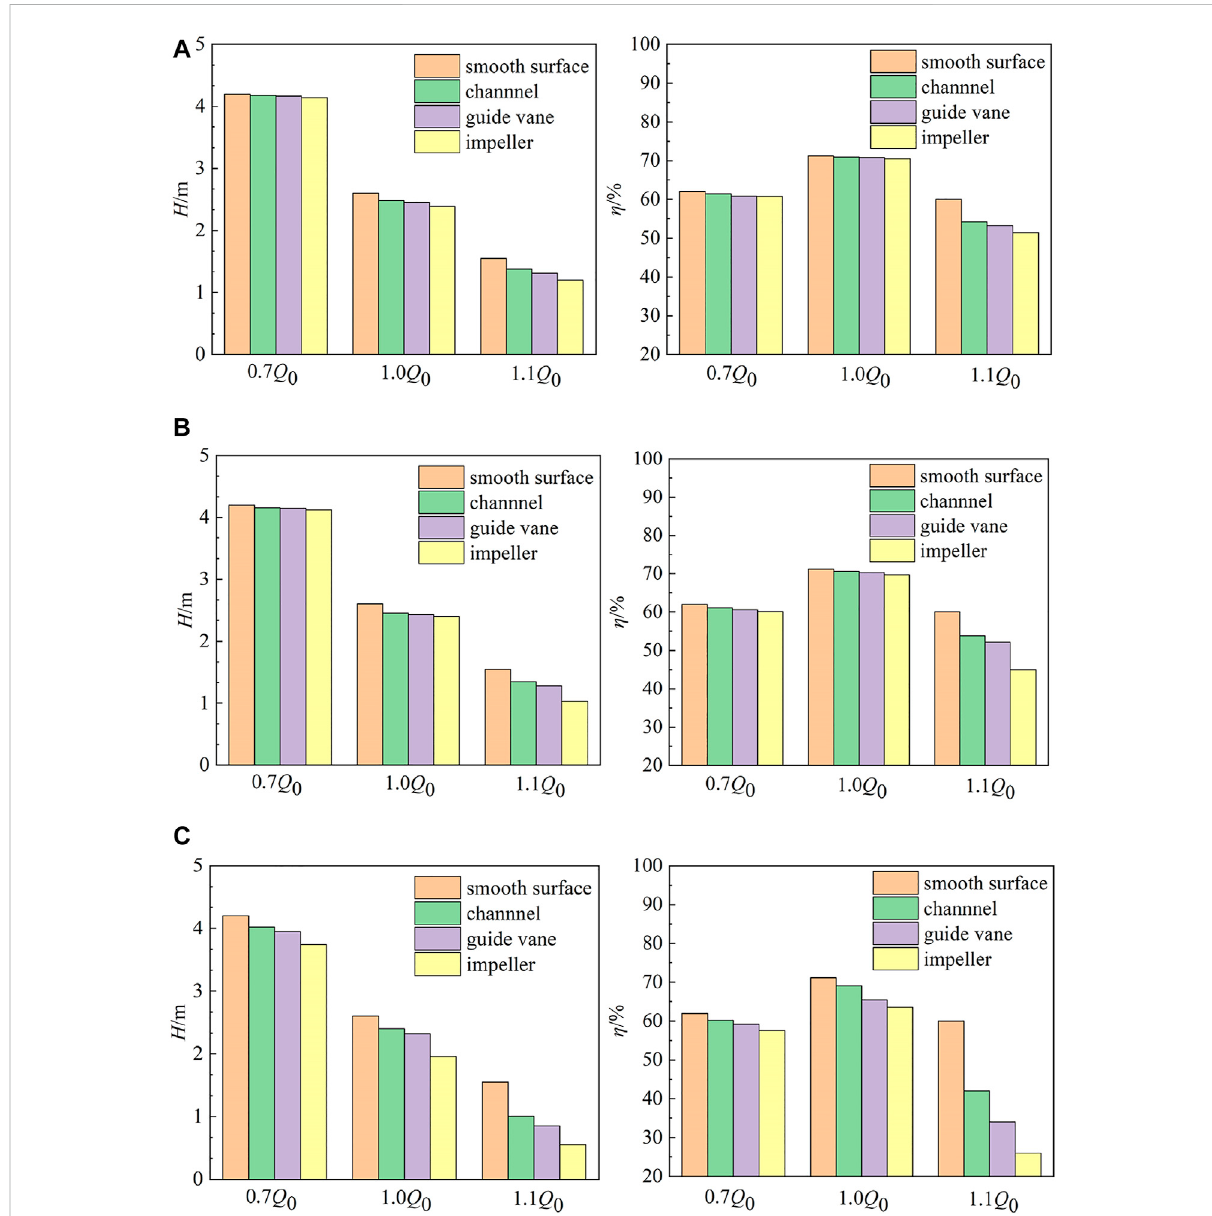
FIGURE 5 Variations in the heads and ef fi ciencies of axial- fl ow pump devices: (A) Ra = 10 μ m, (B) Ra = 100 μ m, and (C) Ra = 1,000 μ